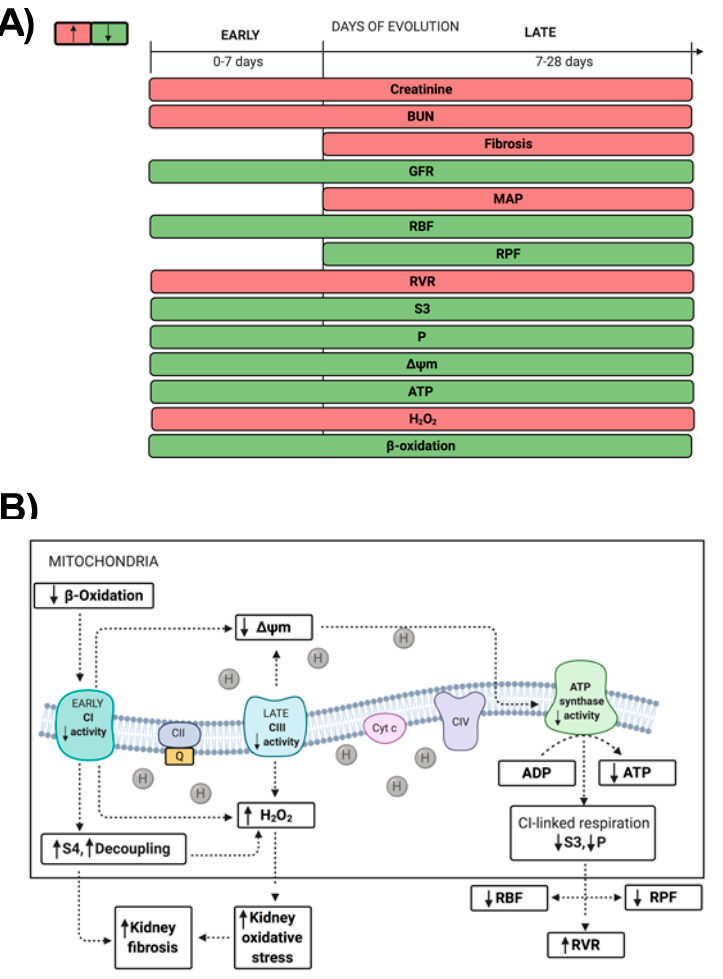
Figure 8. ( A ) Temporal evolution of the pathological change observed in remnant kidney after 5 / 6 nephrectomy (5 / 6Nx). To facilitate analysis, two stages can be identified, an early stage (since the first hours and until day 7) and a late stage (days 7 to 28). The red bars represent an increase in the values of the respective parameters, while the green bars represent a decrease. ( B ) Integrative scheme of the mitochondrial pathological changes and their contribution to CKD development in the 5 / 6Nx model. Up solid line arrow ( ↑ ) indicate an increase in the corresponding parameter. Down solid line arrows ( ↓ ) indicate a decrease in the corresponding parameter. Dotted arrow indicate the proposed relationships between observed changes. BUN = blood urea nitrogen; CI = mitochondrial complex I; CII = mitochondrial complex II; CIII = mitochondrial complex III; CIV = mitochondrial complex IV; Cyt c = cytochrome c ; GFR = glomerular filtration rate; H 2 O 2 = mitochondrial hydrogen peroxide; Q = quinone; P = oxidative phosphorylation-associated respiration; S3 = respiratory state 3; S4o = respiratory state 4 induced by oligomycin; RBF = renal blood flow; RPF = renal plasma flow; RVR = renal vascular resistance; MAP = mean arterial pressure; ∆Ψ m = mitochondrial membrane potential.